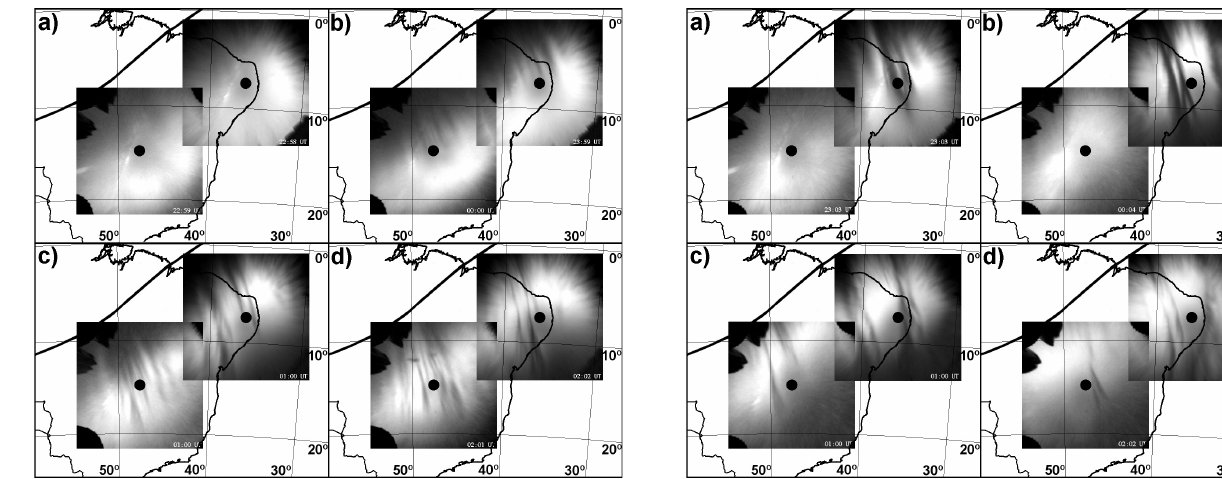
Fig. 6. Four plots showing the evolution of extensive plasma bubbles observed simultaneously from Brasilia and Cariri on 30 September–1 October. The data shown are hourly intervaled from 23:00UT to 02:00UT.